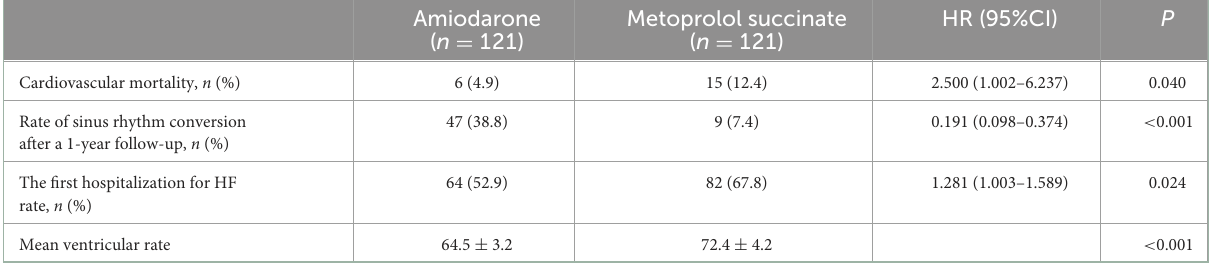
TABLE 2 Cardiovascular mortality, the first hospitalization for HF, and incidence of sinus rhythm conversion after 1-year follow-up.